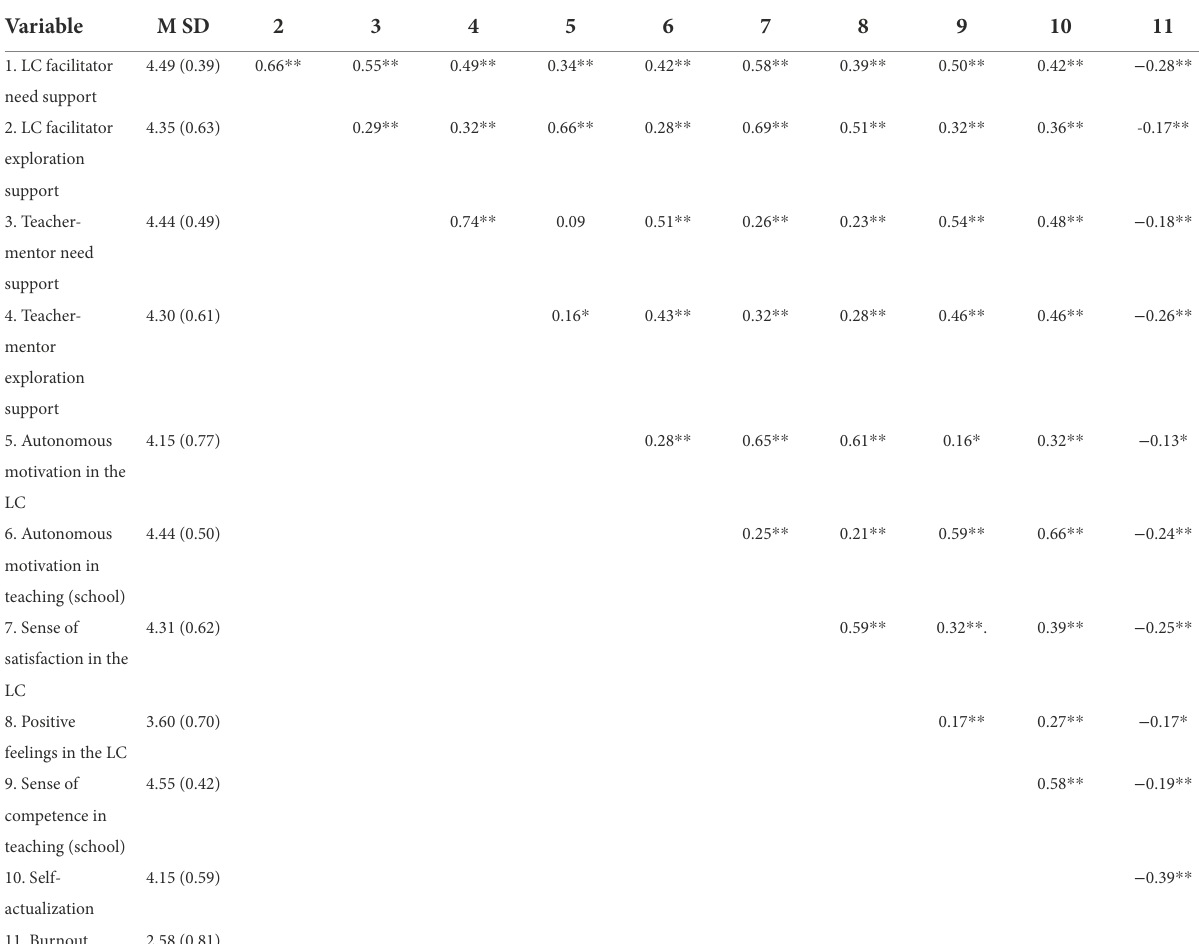
TABLE 3 Descriptive statistics and correlations between the research variables at